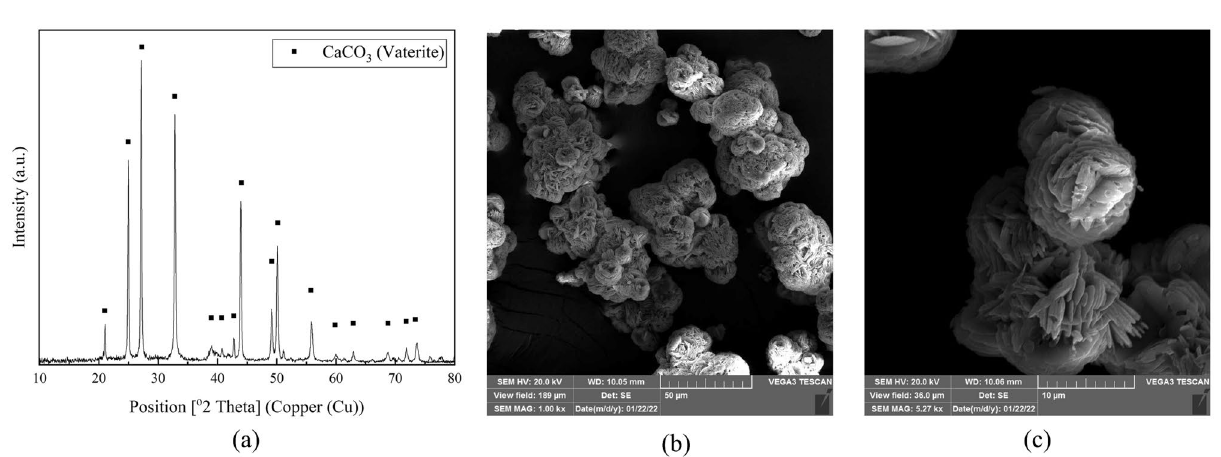
Figure 8. ( a ) XRD spectrum for produced CaCO 3 as compared to vaterite. SEM micrograph of vaterite at magnification of ( b ) 1 kx, and ( c ) 5.27